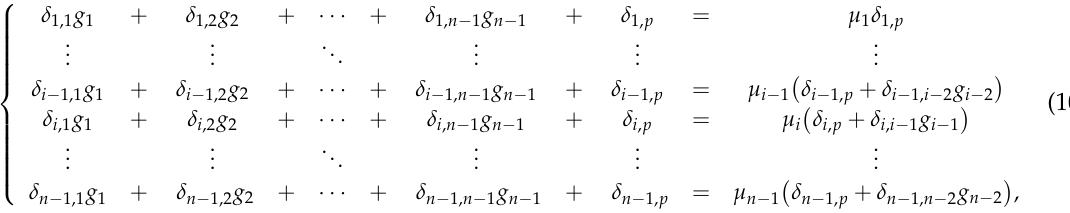
Table 1. Pseudo-code of modified hinged plate method. Algorithm: The load lateral distribution influence line